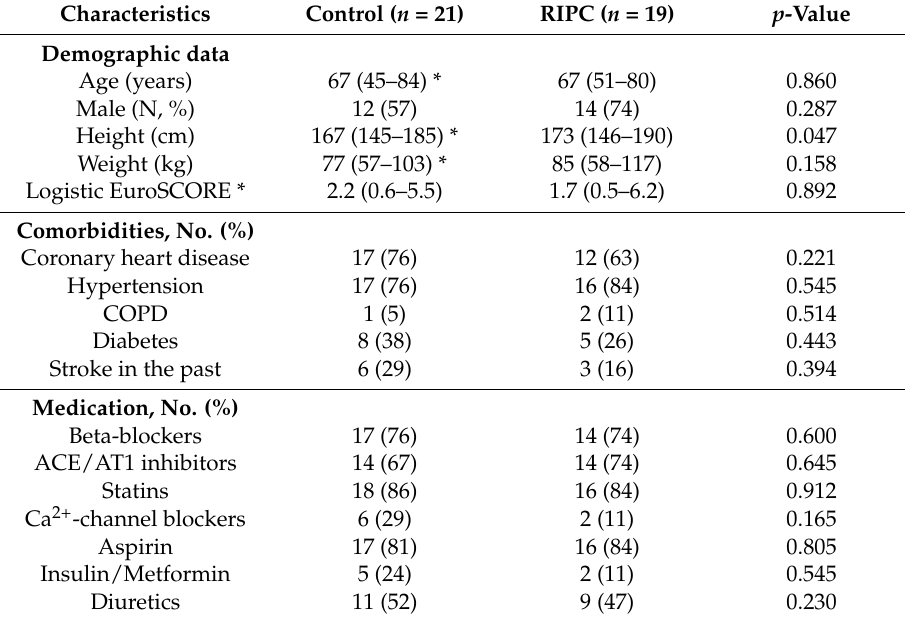
Table 1. Baseline characteristics.